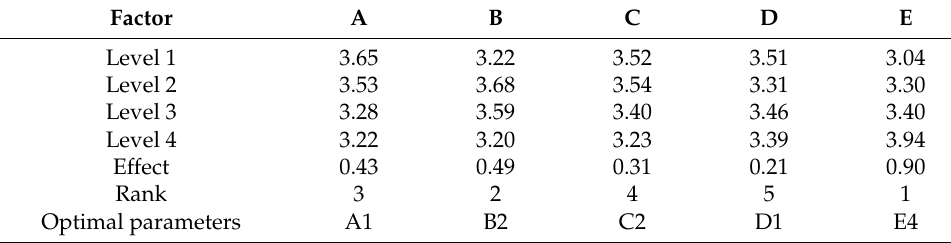
Table 7. Total Warpage Deformation Response.